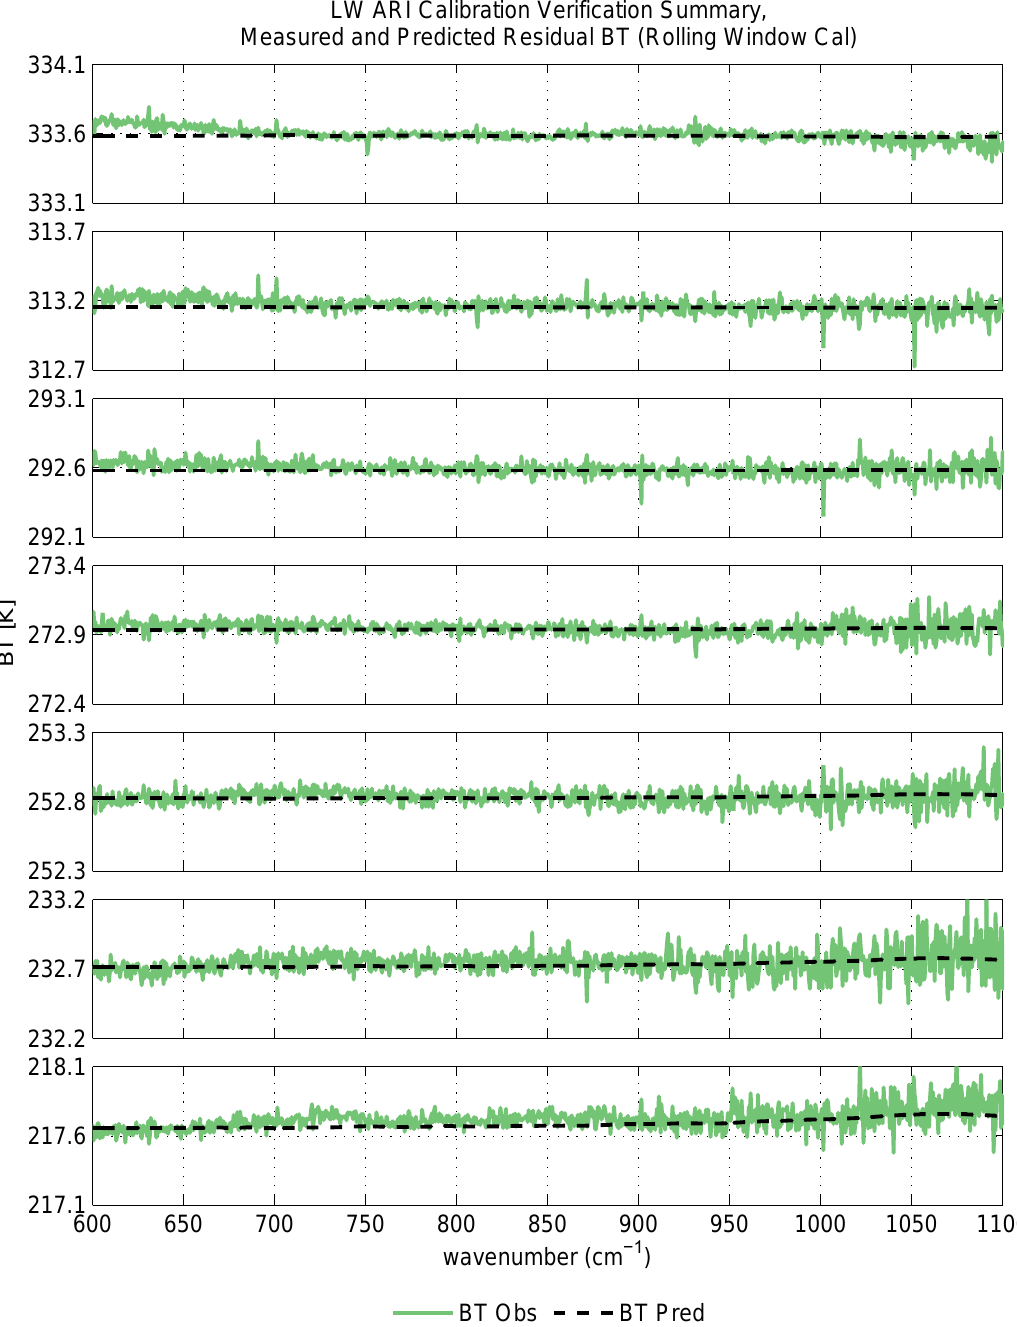
Figure 14. ARI calibration verification results for tests conducted under vacuum. Observed brightness temperature for the long-wave Mercury-Cadmium-Telluride (HgCdTe or MCT) detector is shown in green and the black dashed line indicates predicted brightness OARS brightness temperature.